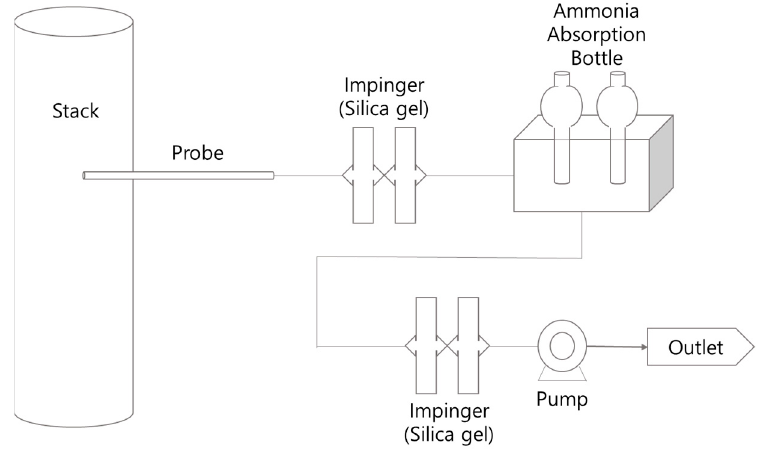
Figure 1. Schematic of the field setup for ammonia sampling in a sewage sludge incinerator.